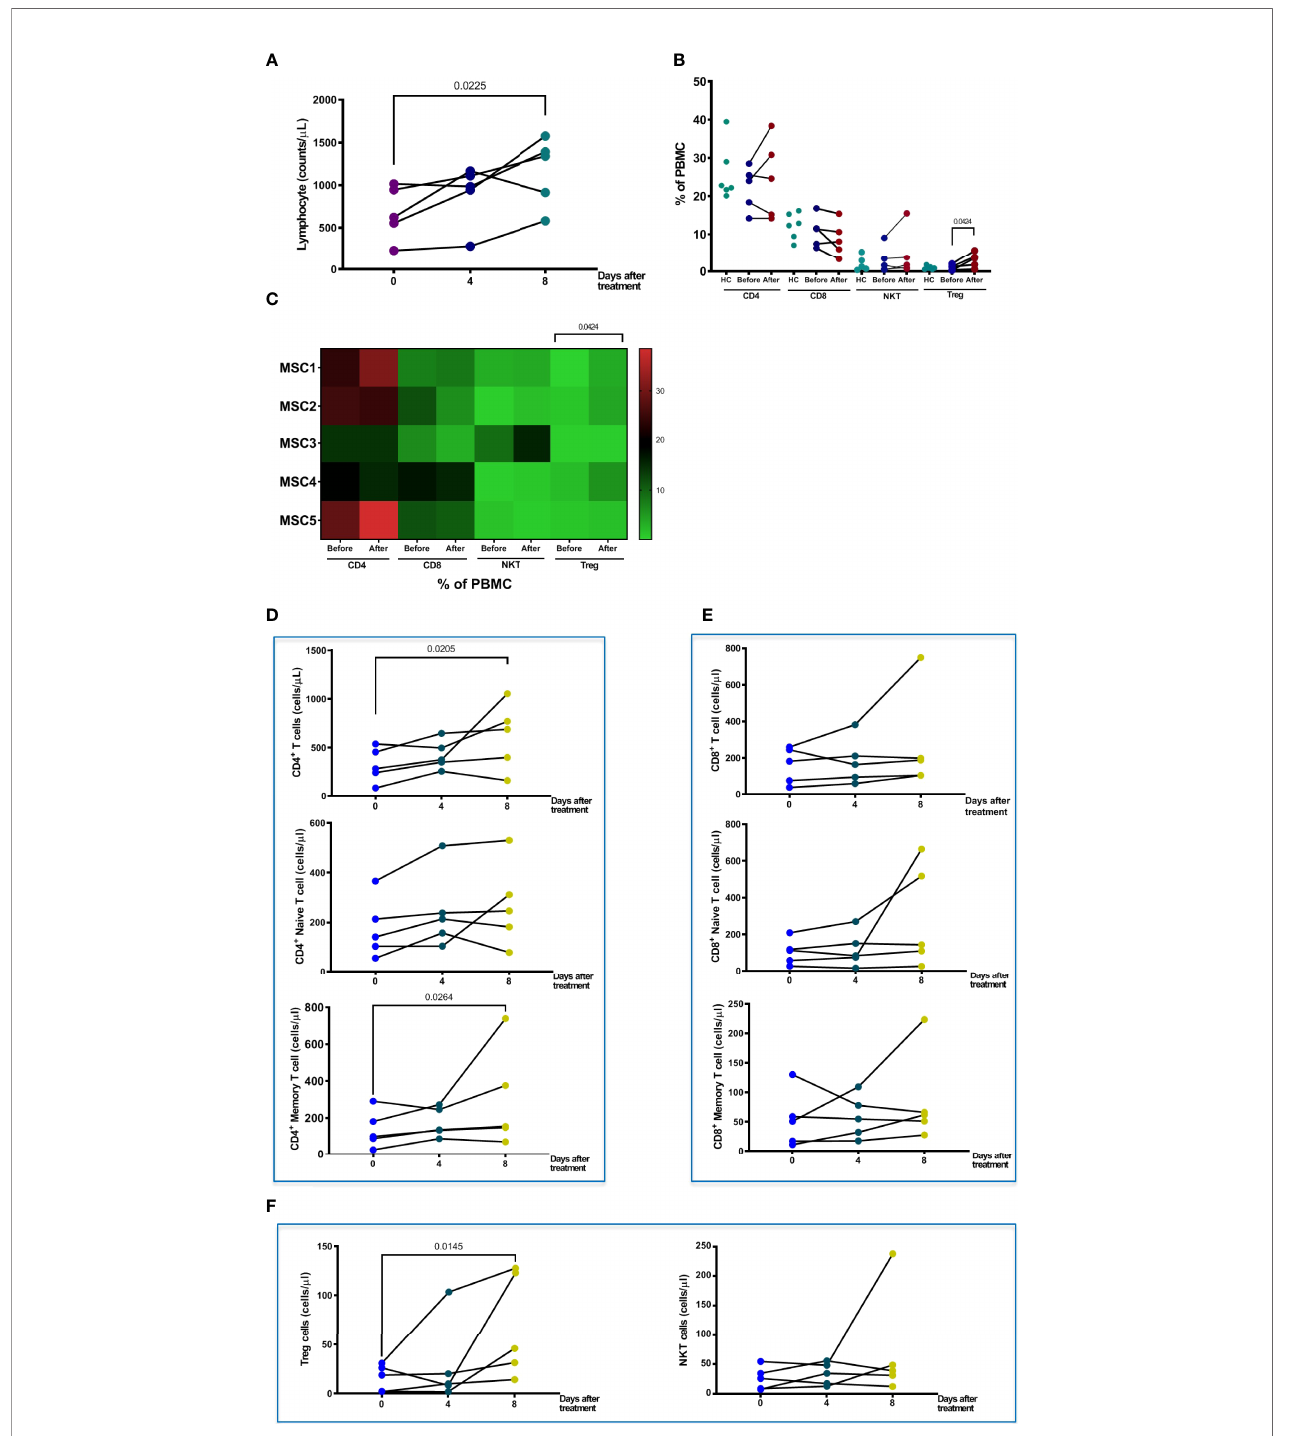
FIGURE 4 | Changes in T cells and sub-populations after pcMSC treatment. (A) Total lymphocyte count changes after Days 0, 4, and 8 of treatment. (B) The proportions of CD4, CD8, NKT, and Treg cells before and after treatment, compared with normal healthy individuals. (C) Distribution of T cells subpopulations was shown in the heat map. (D) The absolute cell number of total CD4 + T cell, naïve CD4 + T cell, and CD4 + memory cell increased after treatment. (E) No change in absolute cell number of CD8 + T cell, CD8 + Naïve T cell, or CD8 + memory T cell. (F) The absolute cell number of Treg cells was signi fi cantly increased after Day 8 of treatment. The P value was as indicated. Nonparametric Wilcoxon sign-rank